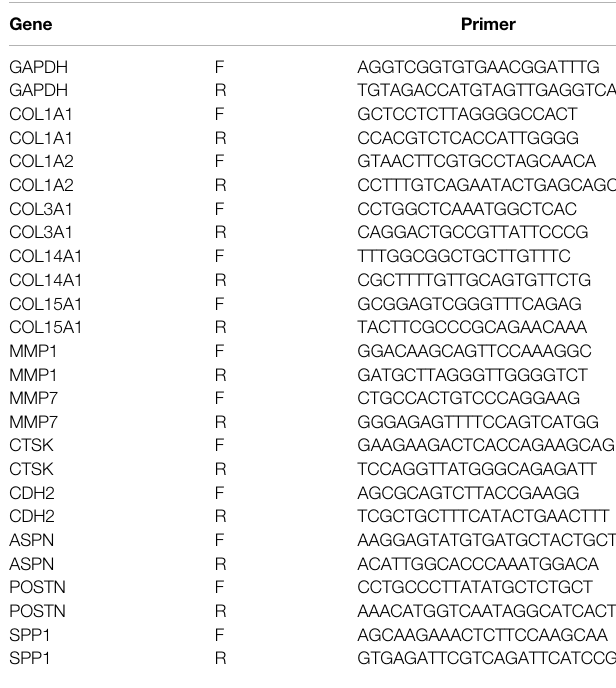
TABLE 2 | Real-time PCR